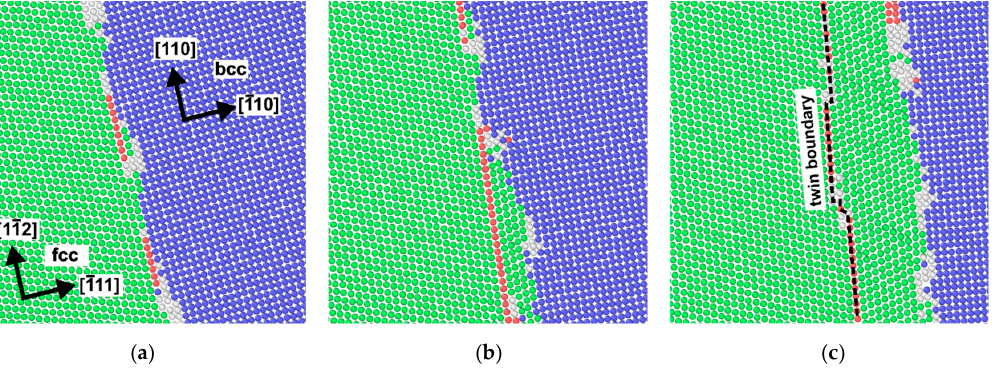
Figure 15. Twinning in the lamella of a large grain during shear. Cross-section of the structure by the fcc (110) plane at different shear strains: 0.000 ( a ), 0.065 ( b ), and 0.088 ( c ). Atoms with bcc, fcc, hcp, and uncertain neighbor symmetry are shown in blue, green, red, and light gray, respectively.